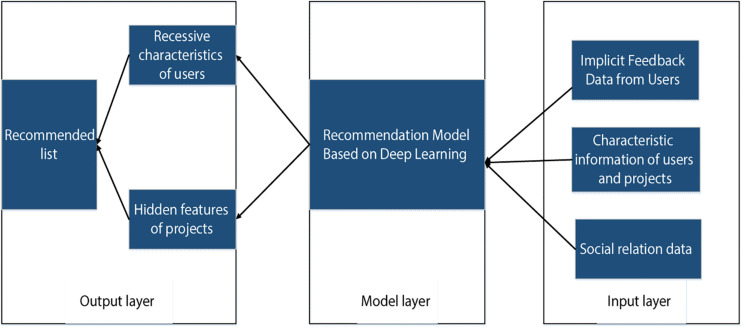
Schematic diagram of traditional deep learning recommendation.